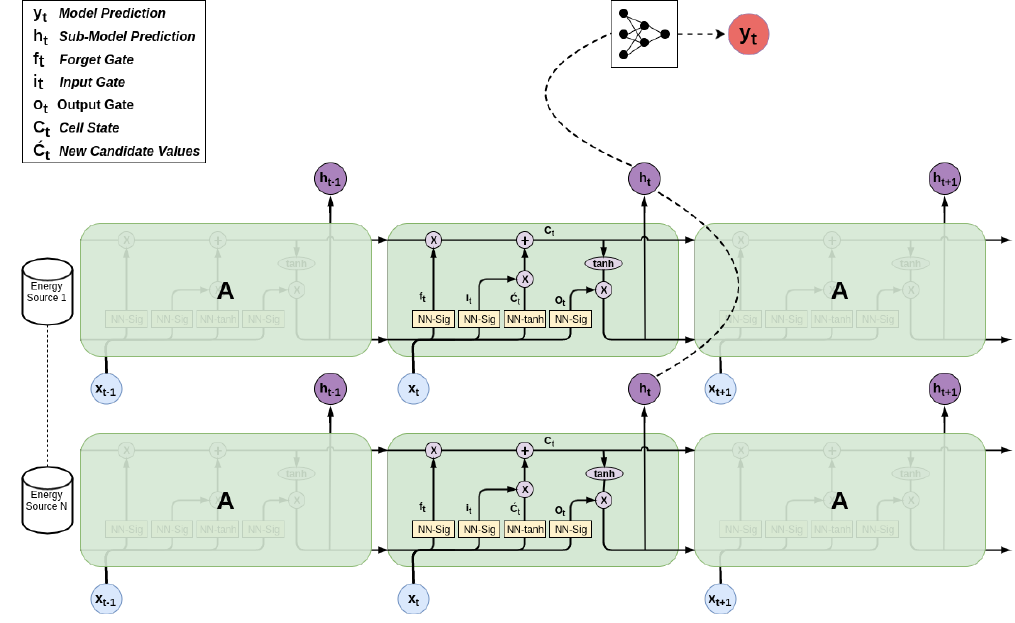
Figure 3. A Recurrent Neural Network’s implementation of a Long Short Term Memory model.